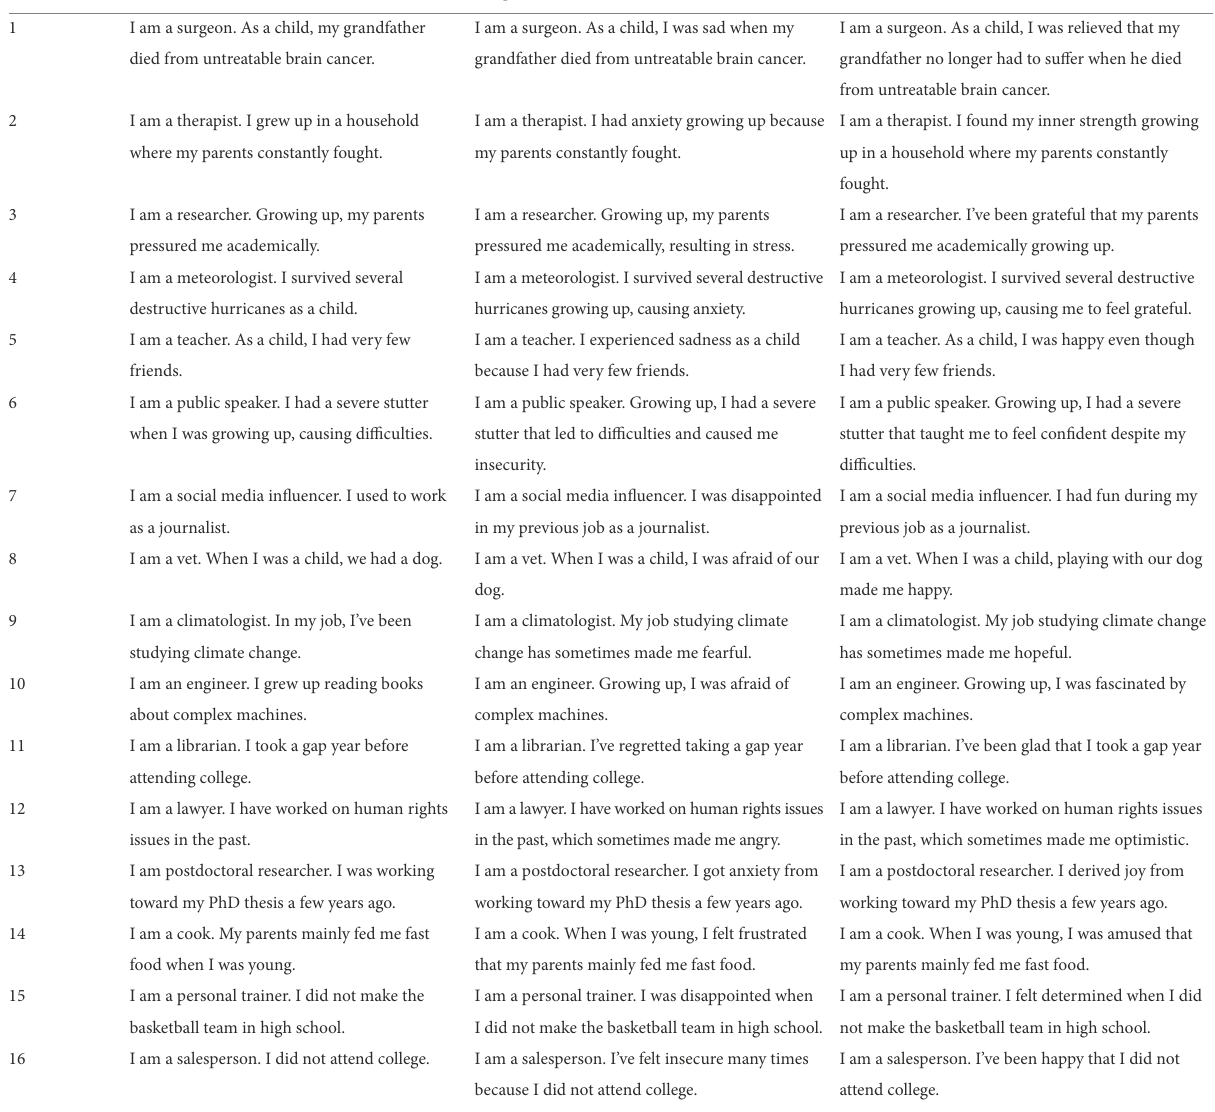
TABLE 2 Text material used in the rating